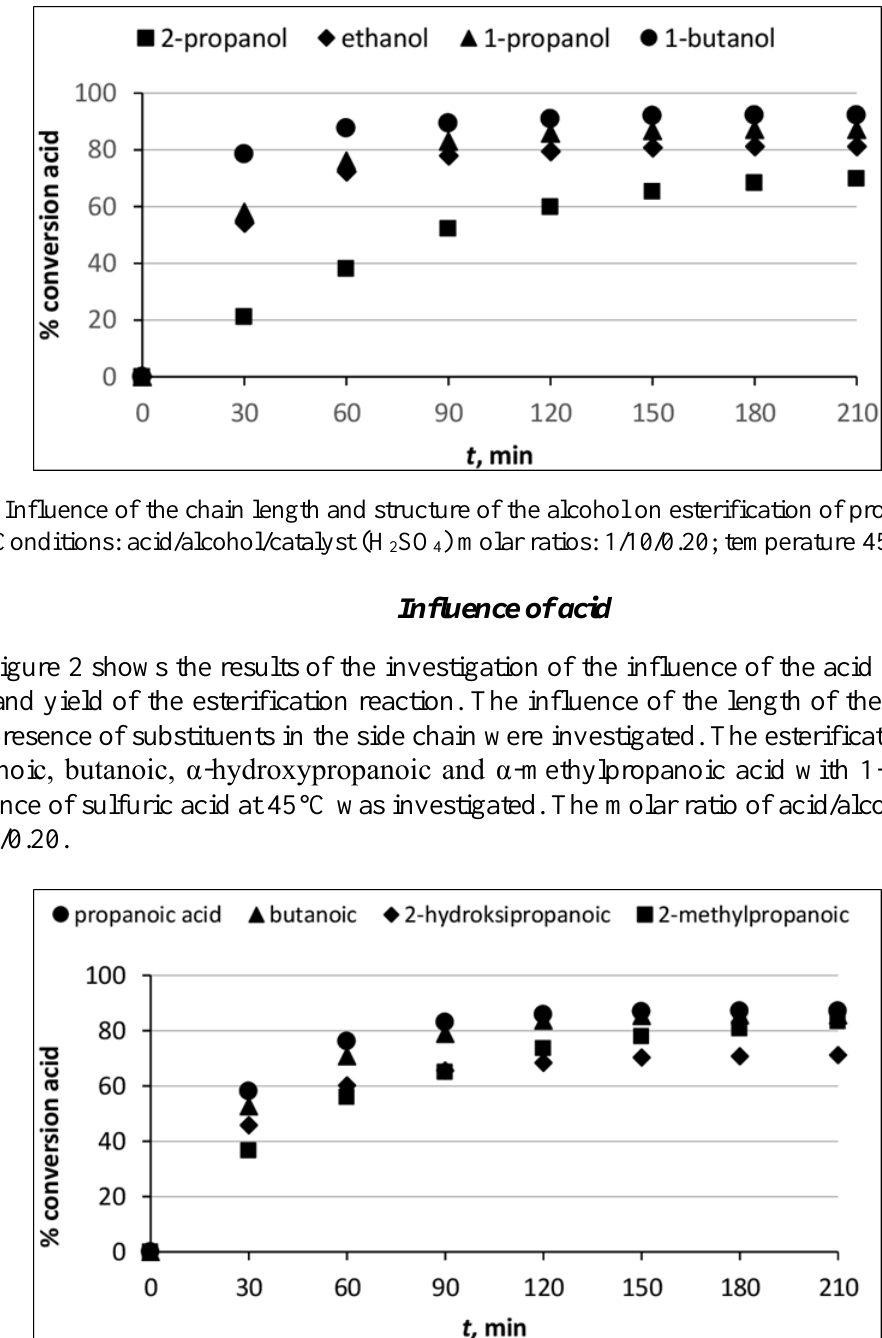
SO ) was 1/10/ 0.20; temperature 2 4